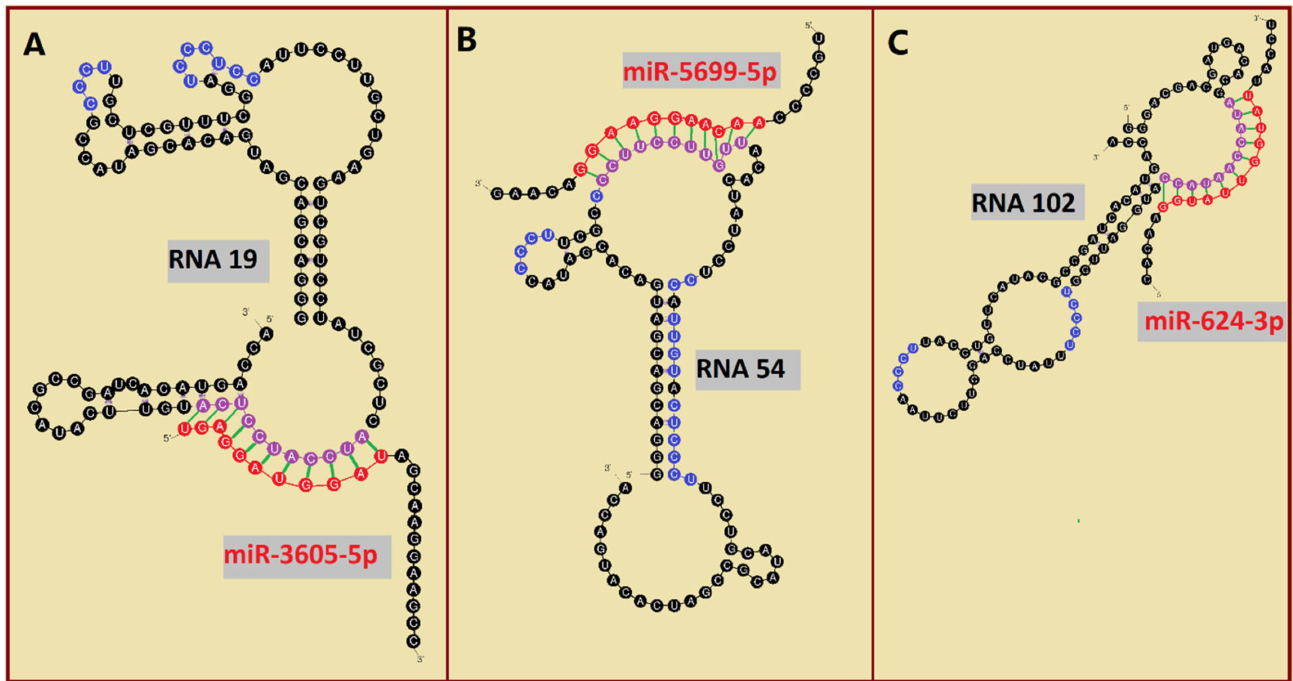
Figure 4. Binding of human miRNAs to bifunctional RNA aptamers containing both raft- and miRNA-binding motifs. ( A ) RNA 19 interacting with miR-3605-5p. ( B ) RNA 54 interacting with miR-5699-5p. ( C ) RNA 102 interacting with miR-624-3p. The RNA aptamer’s raft-binding motifs are marked in blue, and the miRNA-binding motif is marked in purple. The miRNA reversed/complement motif is marked in